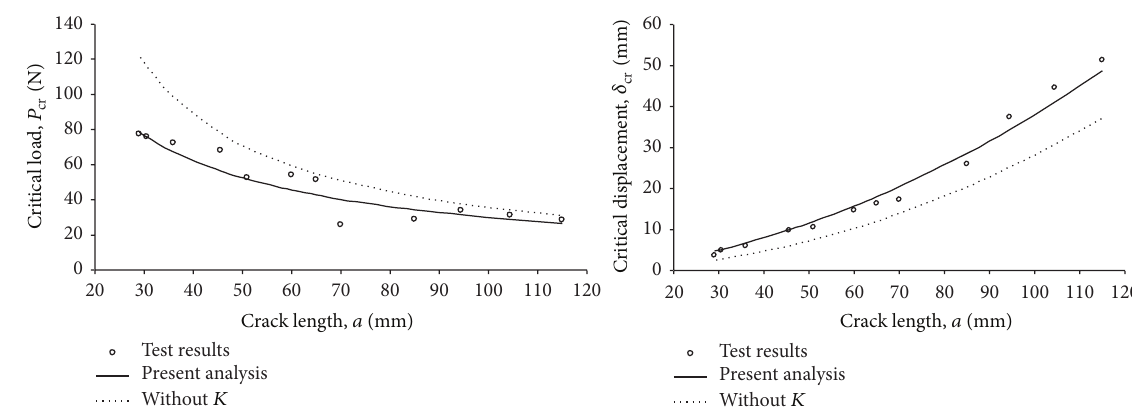
) and the corresponding dis- cr